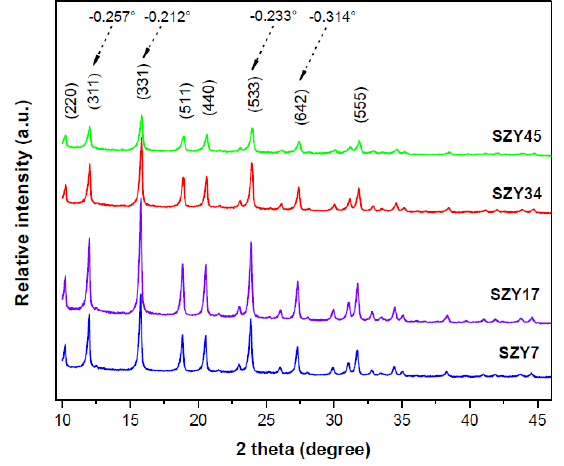
Table 3. Physicochemical properties and composition of the spent zeolites. Figure 11. X-ray powder diffractograms of the spent Y-type zeolites.